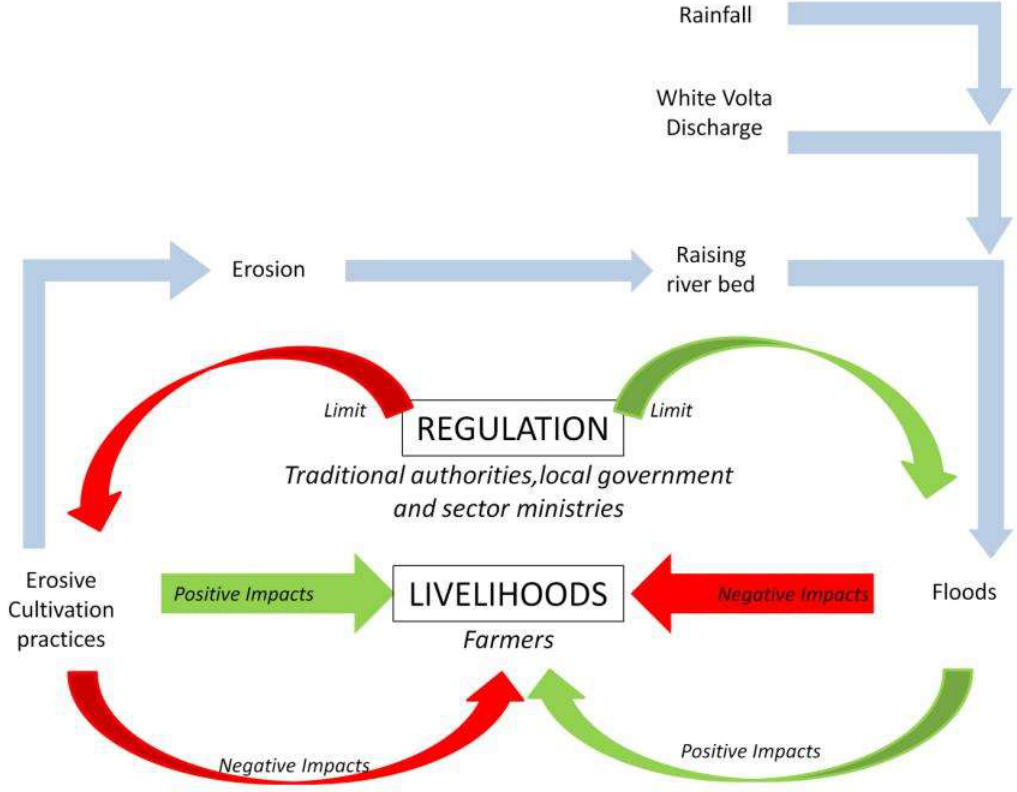
Figure 8. Schematic illustration of the Bawkudo problemshed (the temporal dimension of the problemshed whereby the impact of farming practices only play out after they are conducted is not represented in the graph).